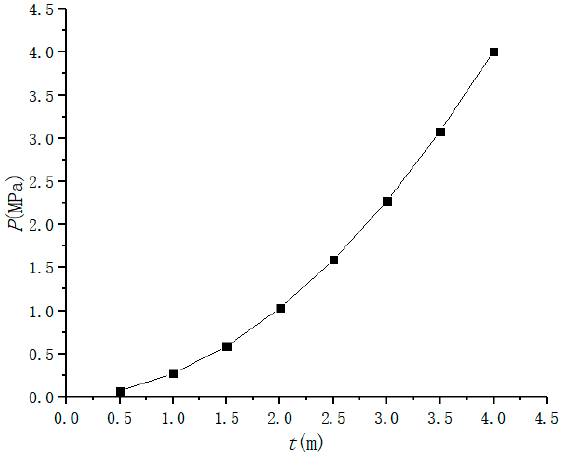
Figure 10. Relationship curve between water pressure and thickness of the floor safety barrier.